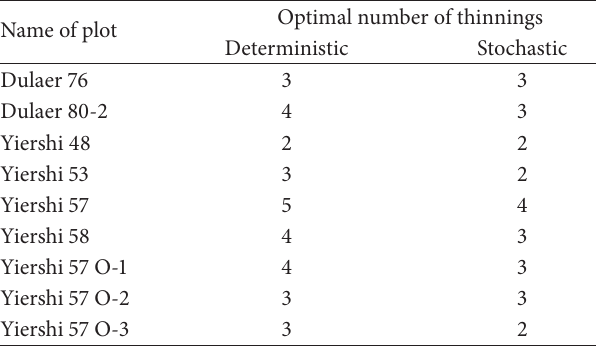
indicates that the numbers of thinnings for most plots are decreased in the stochastic case.